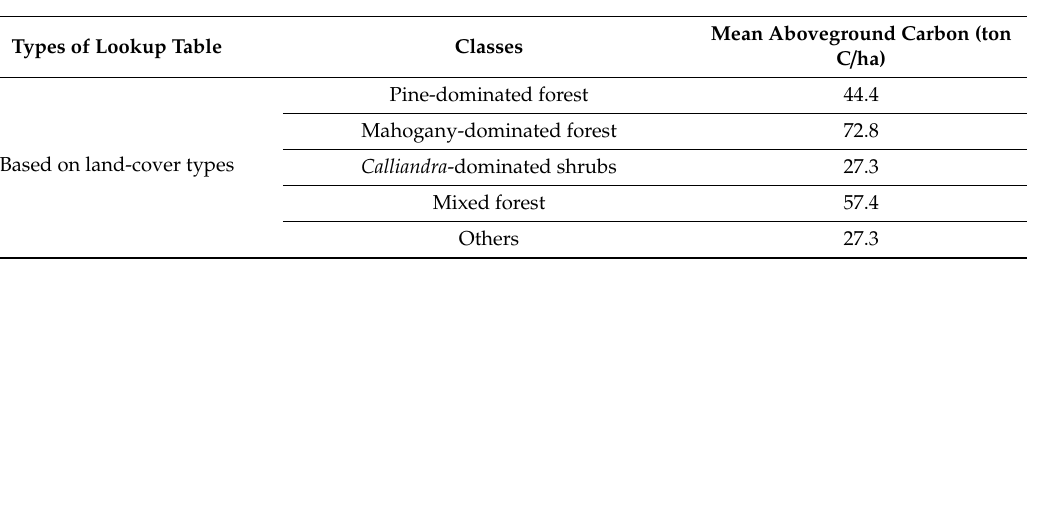
Table 3. Mean values of above ground carbon used for the lookup table